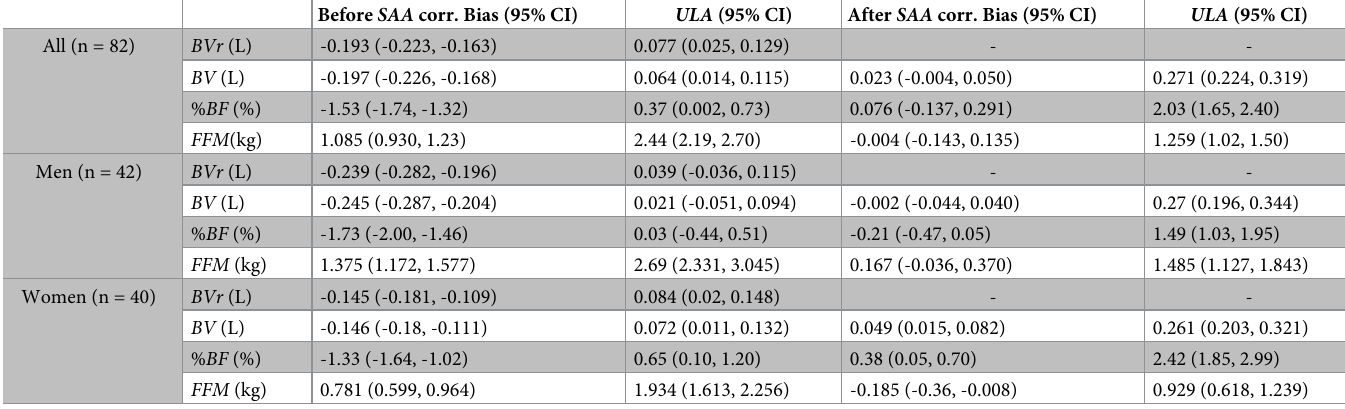
Table 3. Results of the Bland-Altman analysis of body composition parameters derived in relaxed position and compact position (relaxed—compact), before and after the surface area artifact ( SAA ) correction performed using Eq (3). Listed are the bias and the upper limit of agreement ( ULA ) along with their 95% confidence intervals